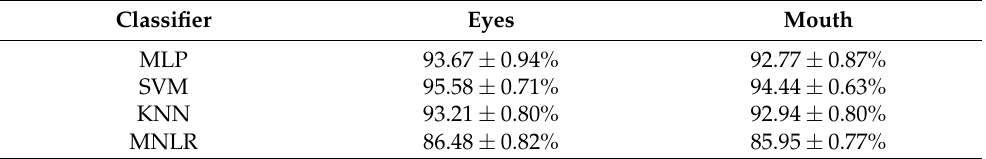
Table 13. Results on the palsy lesion assessment on the criteria of accuracy using the 29 symmetry features.